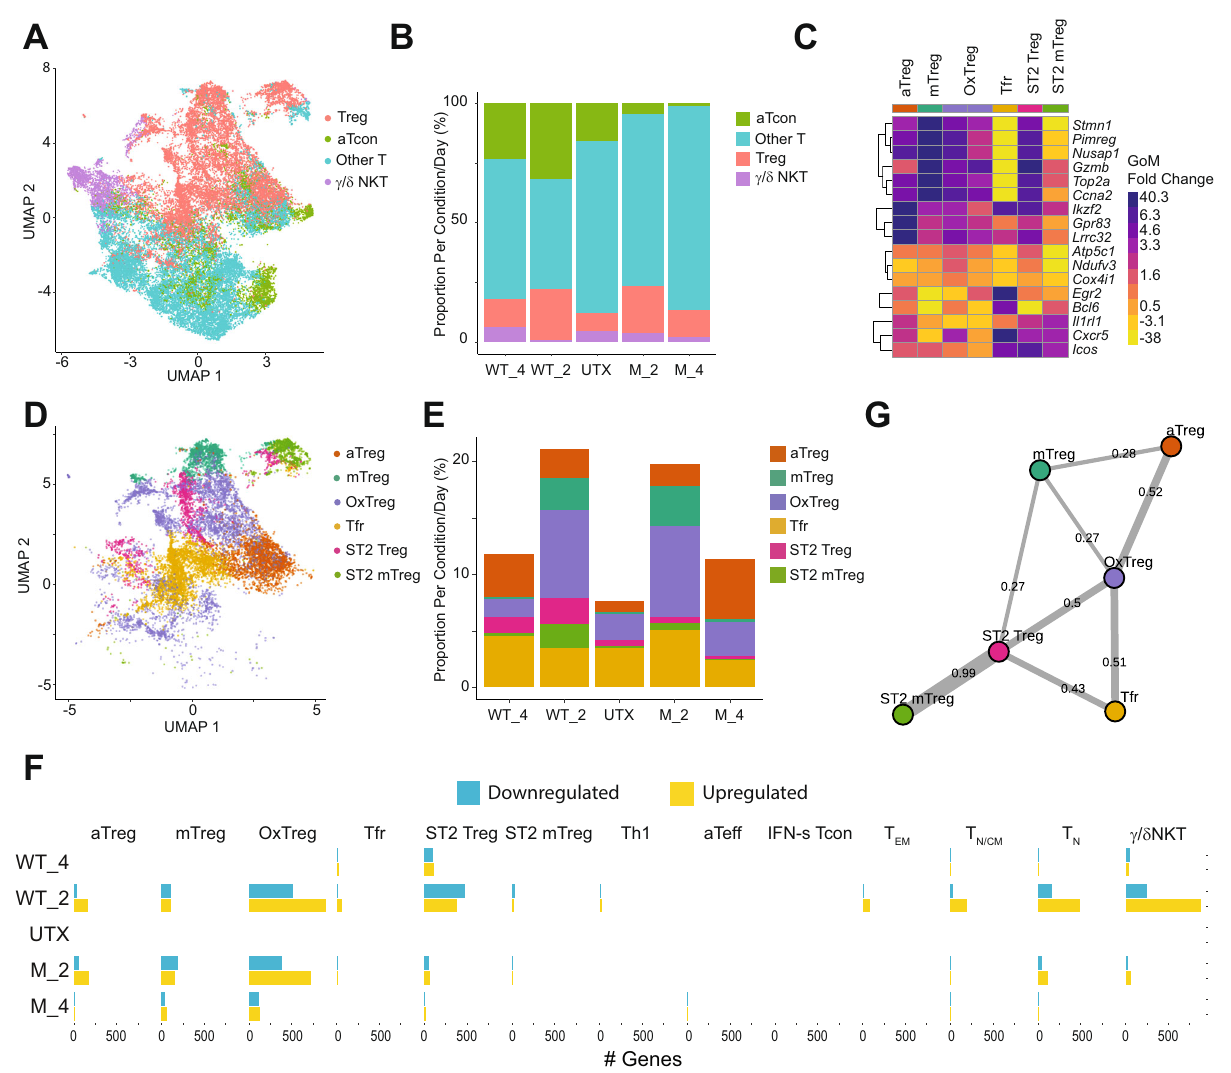
Fig. 5 Single cell transcriptomic of splenic CD4 T cells in naïve and HSA-IL2wt/m treated mice. Cells were harvested either 2- or 4-days post-treatment from n = 2 mice per treatment condition. A Uniform manifold approximation and projection (UMAP) embedding of single-cell gene expression pro fi les (dots) colored by family. B Frequency of cells by family assignment and treatment condition (UTX: Untreated; WT_2, WT_4: Day 2 and Day 4 after HSA- IL2wt ; M_2, M_4: Day 2 and Day 4) after HSA-IL2m treatment. C Differentially-expressed genes characterizing each Treg topic. Color corresponds to log2- fold-change of mean gene expression for all cells assigned to topic k vs all other topics weighted by membership weights. D UMAP embedding of single- cell expression pro fi le colored by Treg topics. E Frequency of Treg topics colored by treatment condition. F Treatment induced differentially-expressed genes by topics. G Treg cell state association graph reconstructed using partition-based graph abstraction (PAGA). Edge width corresponds to connectivity between Treg topics. Source data are provided as a Source Data fi